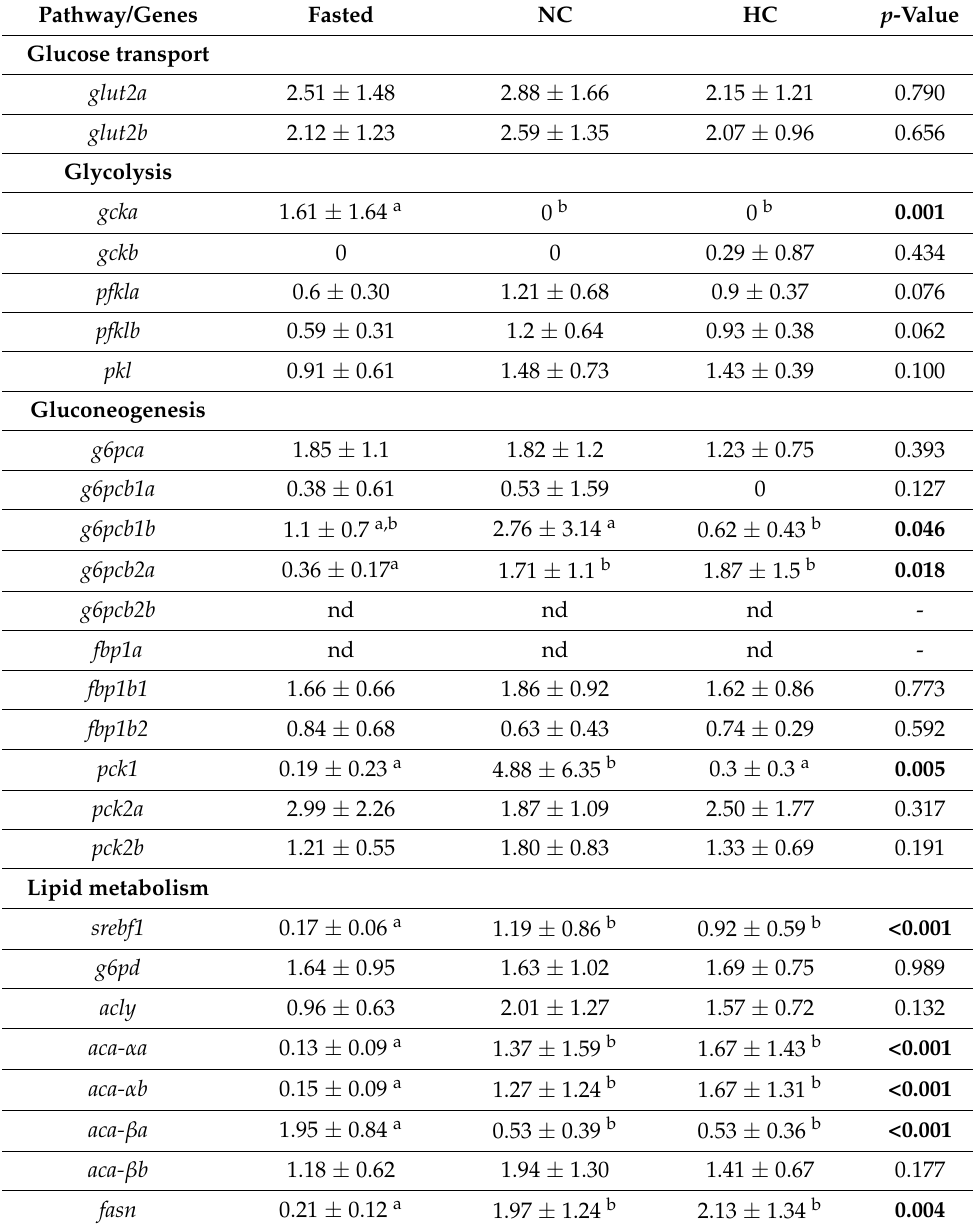
Table 2. Relative mRNA levels of glucose and lipid metabolism-related genes in liver of fasted mature male rainbow trout (Fasted), fed with a non-carbohydrate diet (NC) or fed with a high- carbohydrate diet (HC). Data are represented as means ± SD ( n = 9 males per condition). Genes which have not been detected are represented by “nd”. Data were analysed using one-way ANOVA when conditions of application were respected, otherwise the Kruskal–Wallis test was performed. Significant differences of means were analysed using post hoc Tukey’s test and are represented using different letters ( a , b ) and bold p